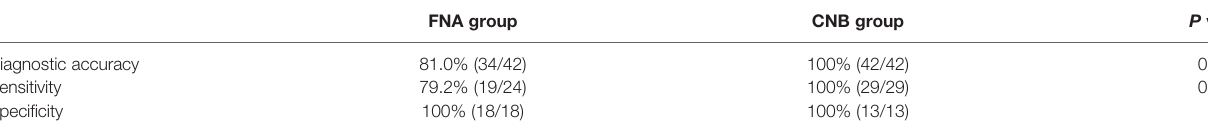
TABLE 4 | Diagnostic ef fi cacy for lymph nodes in the two groups.